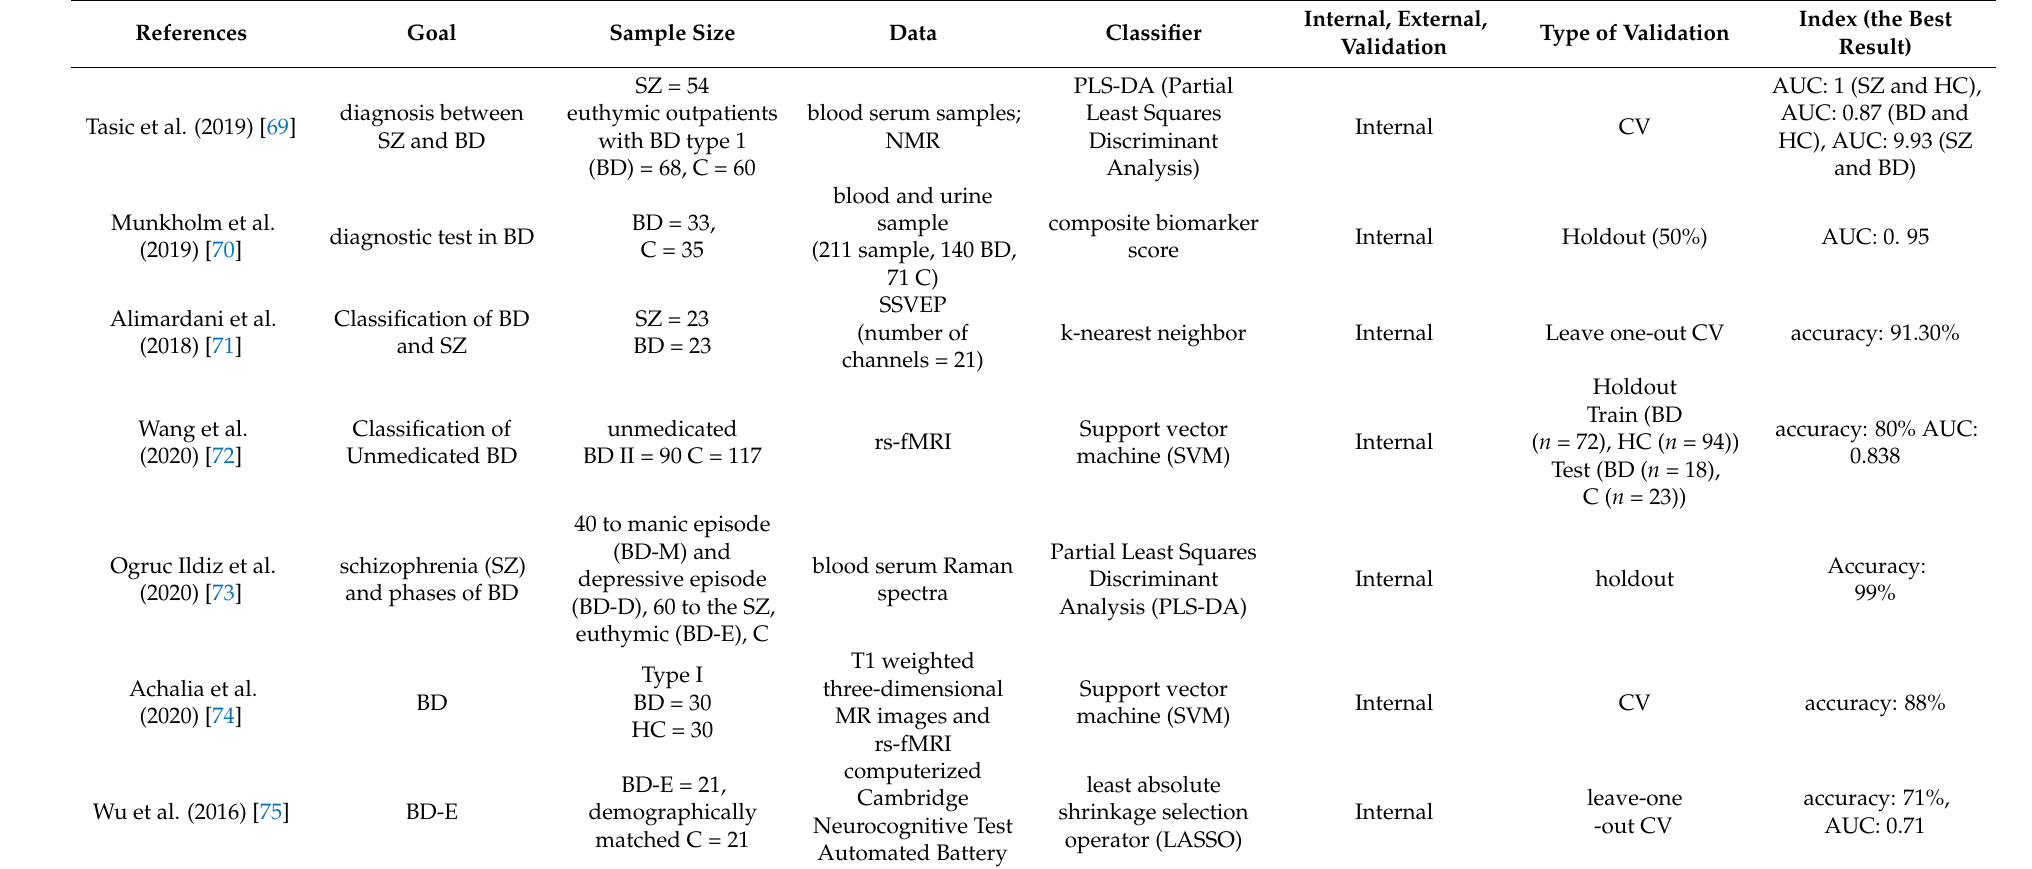
Table 2. CAD methods for mental and neurological disorders